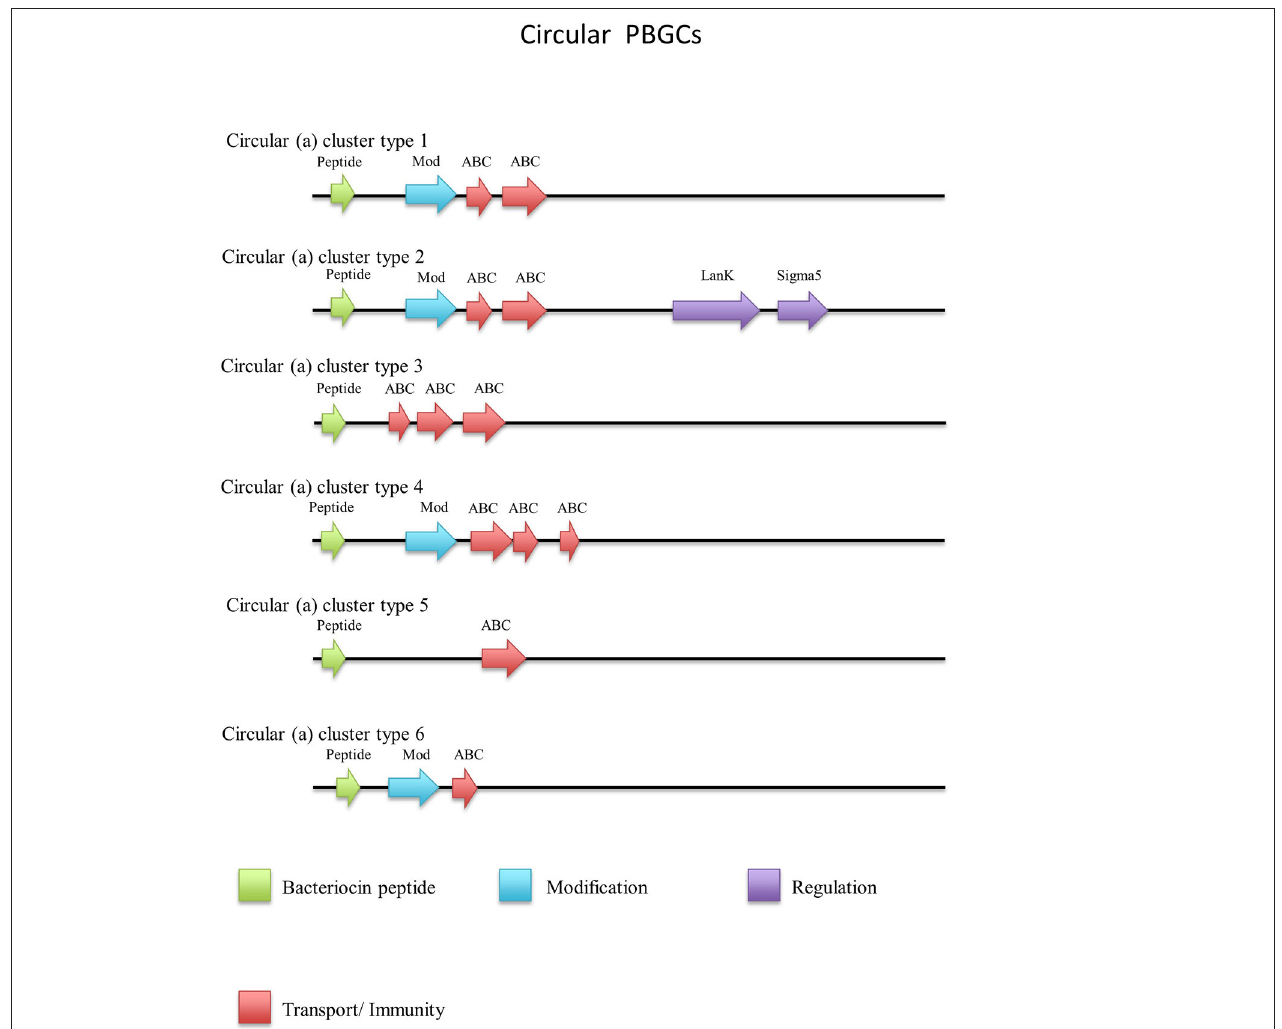
FIGURE 9 | Circular (a) cluster types predicted by